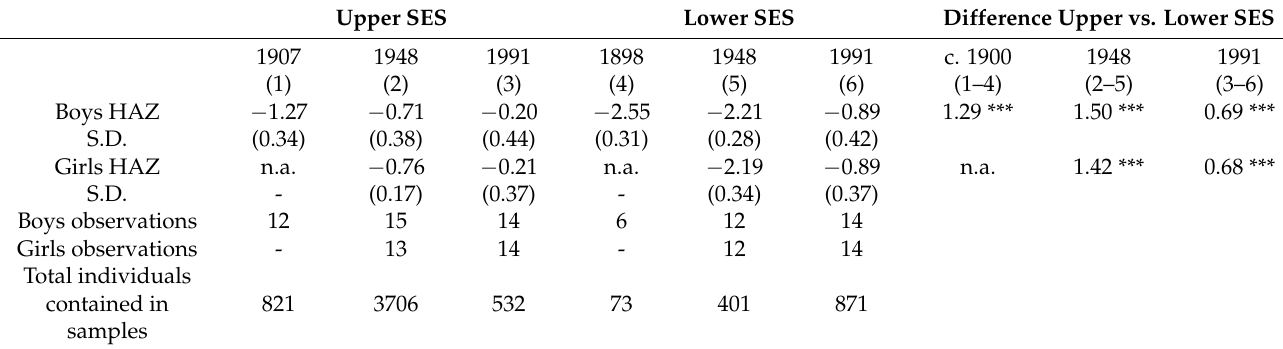
Table 3. Mean HAZ scores of selected upper and lower SES samples, boys and